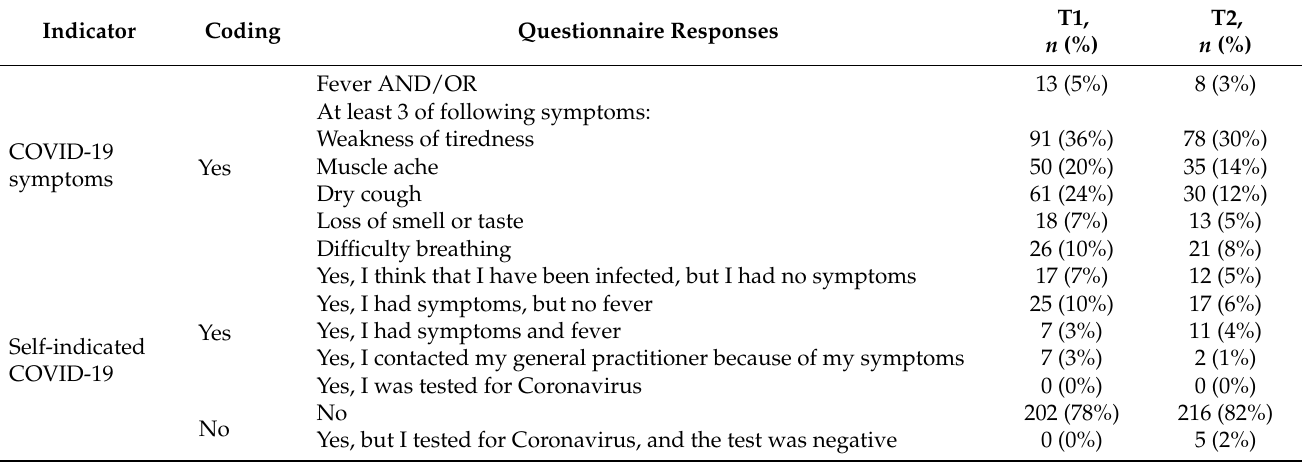
Table 1. COVID-19 indicator coding based on questionnaire responses of the study sample ( n =